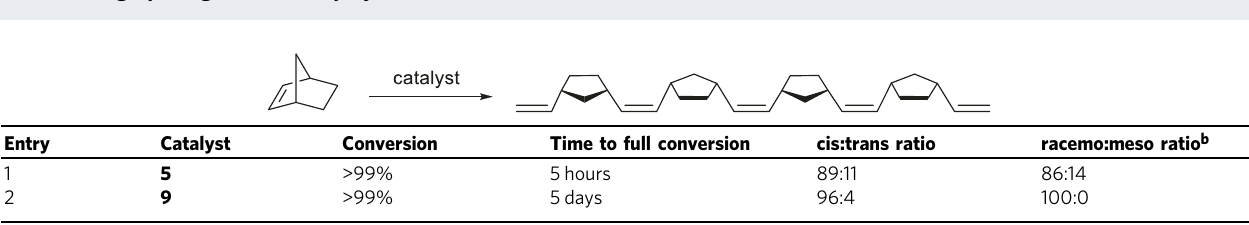
Table 3 Ring-opening-metathesis polymerization of norbornene a